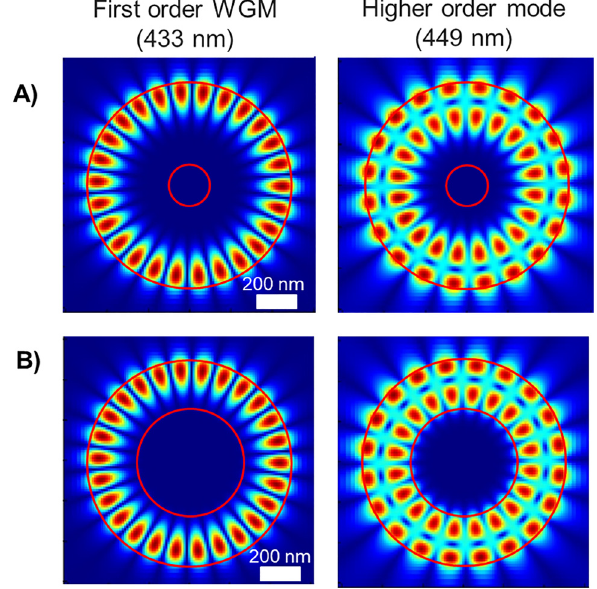
Figure 3: FDTD simulations of microrings. (A) A microring with a 200-nm inner diameter and 1- μ m outer diameter. The concentric red circles superimposed on the E-field profiles represent the inner and outer diameters of the